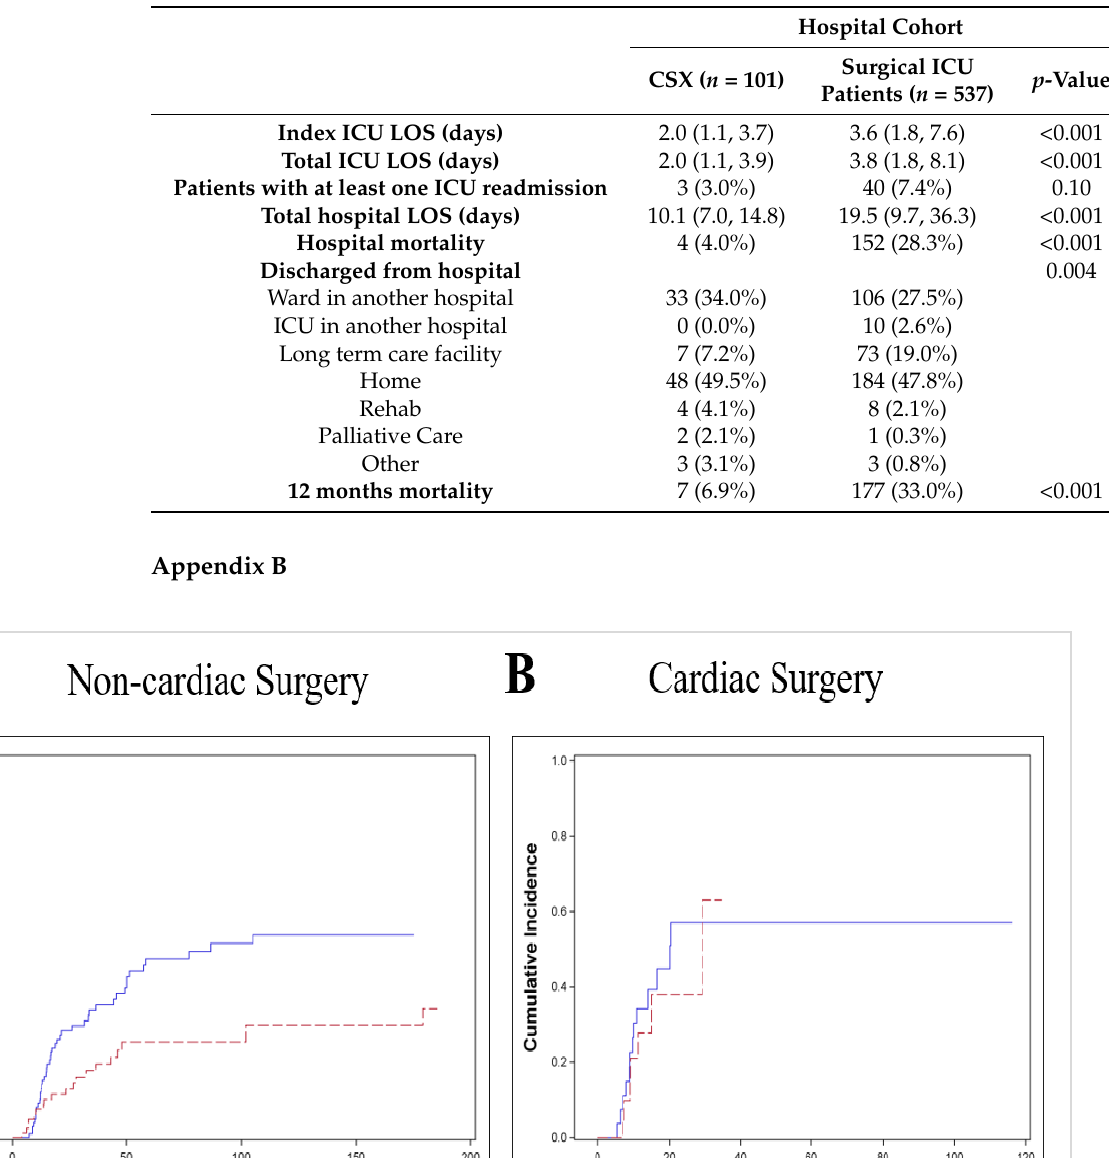
Table A2. Clinical outcomes in longitudinal and hospital groups, presented as median (Q1–Q3) or number and count (%). Abbreviations: LOS = Length of stay, ICU = Intensive Care Unit.